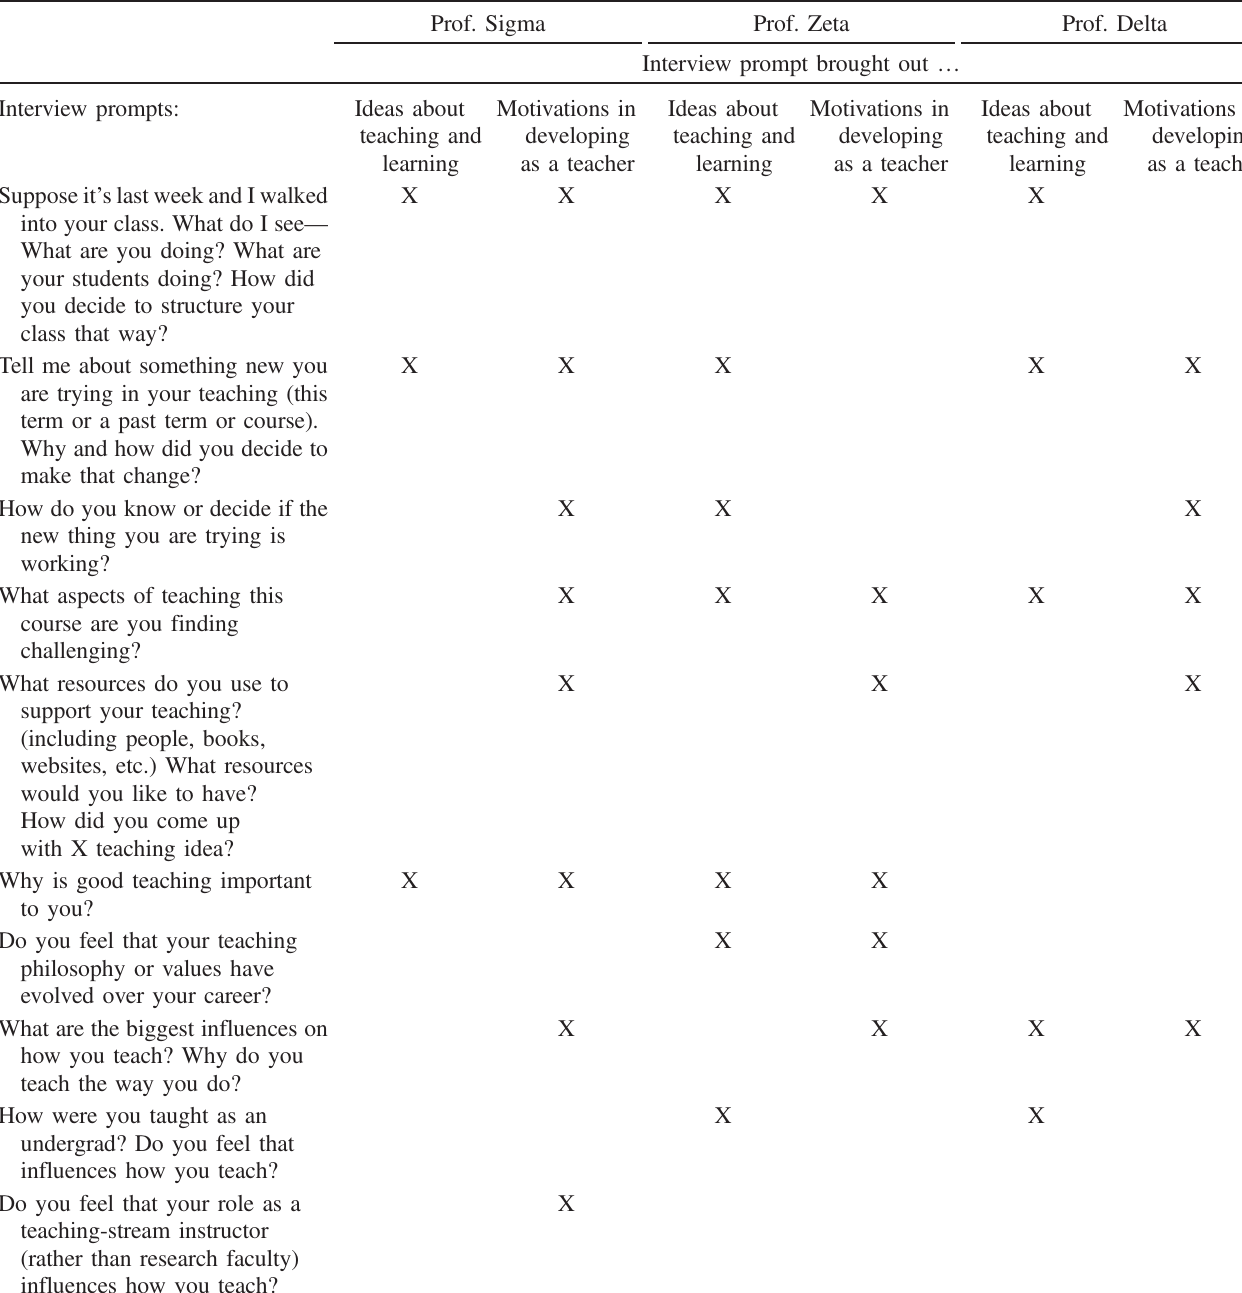
TABLE III. Interview prompts that brought out ideas about teaching and learning, and motivations in developing as a teacher, for each case study